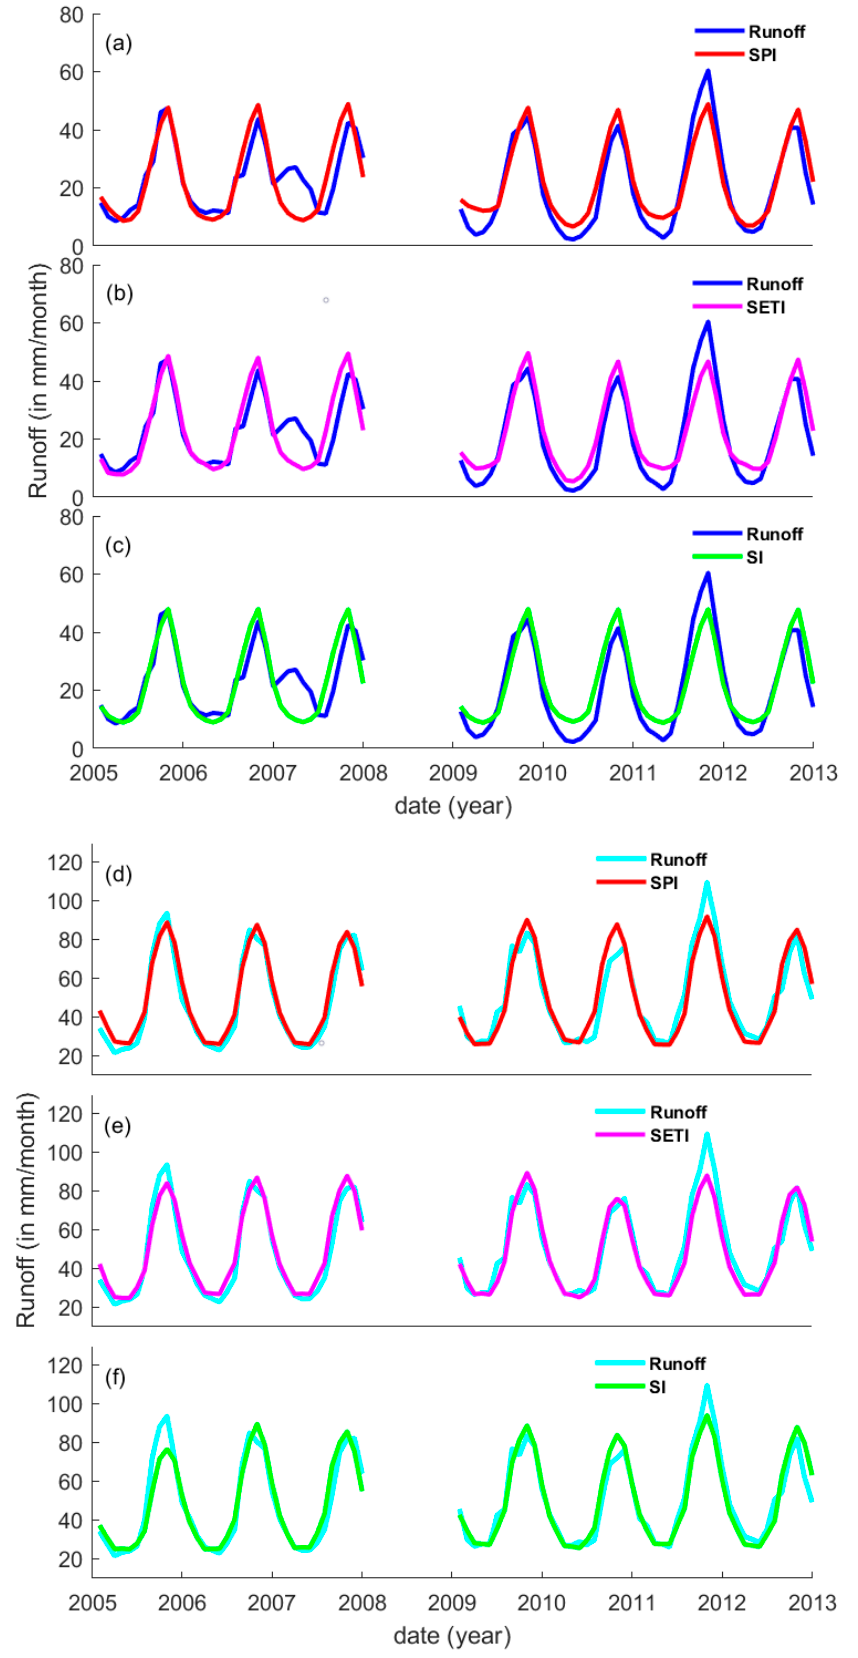
Figure 9. Reconstructed runoff estimates, based on ( a ) and ( d ) SPI, ( b ) and ( e ) SETI, and ( c ) and ( f ) SI, at ( a ), ( b ) , and ( c ) My Thuan and ( d ), ( e ) , and ( f ) Tan Chau stations.